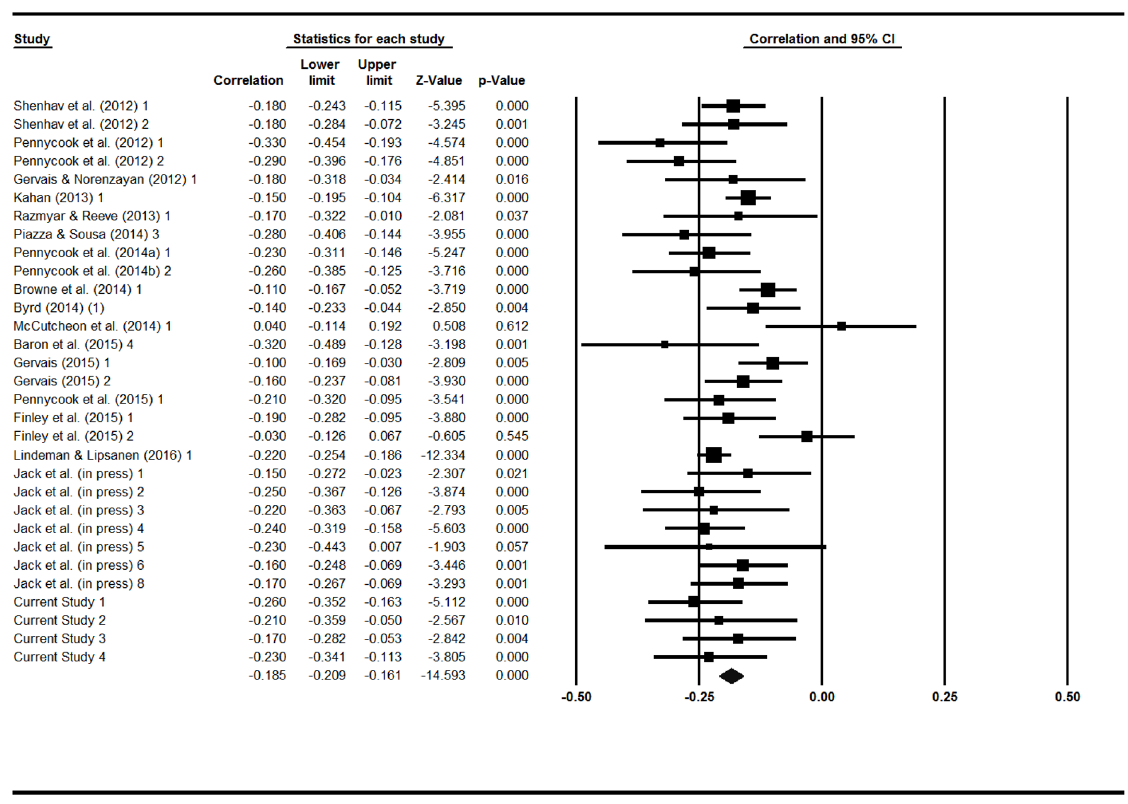
Fig 3. Forest plot of random effect meta-analysis showing effect sizes ( r ) for the association between religious belief scales and performance on the CRT.